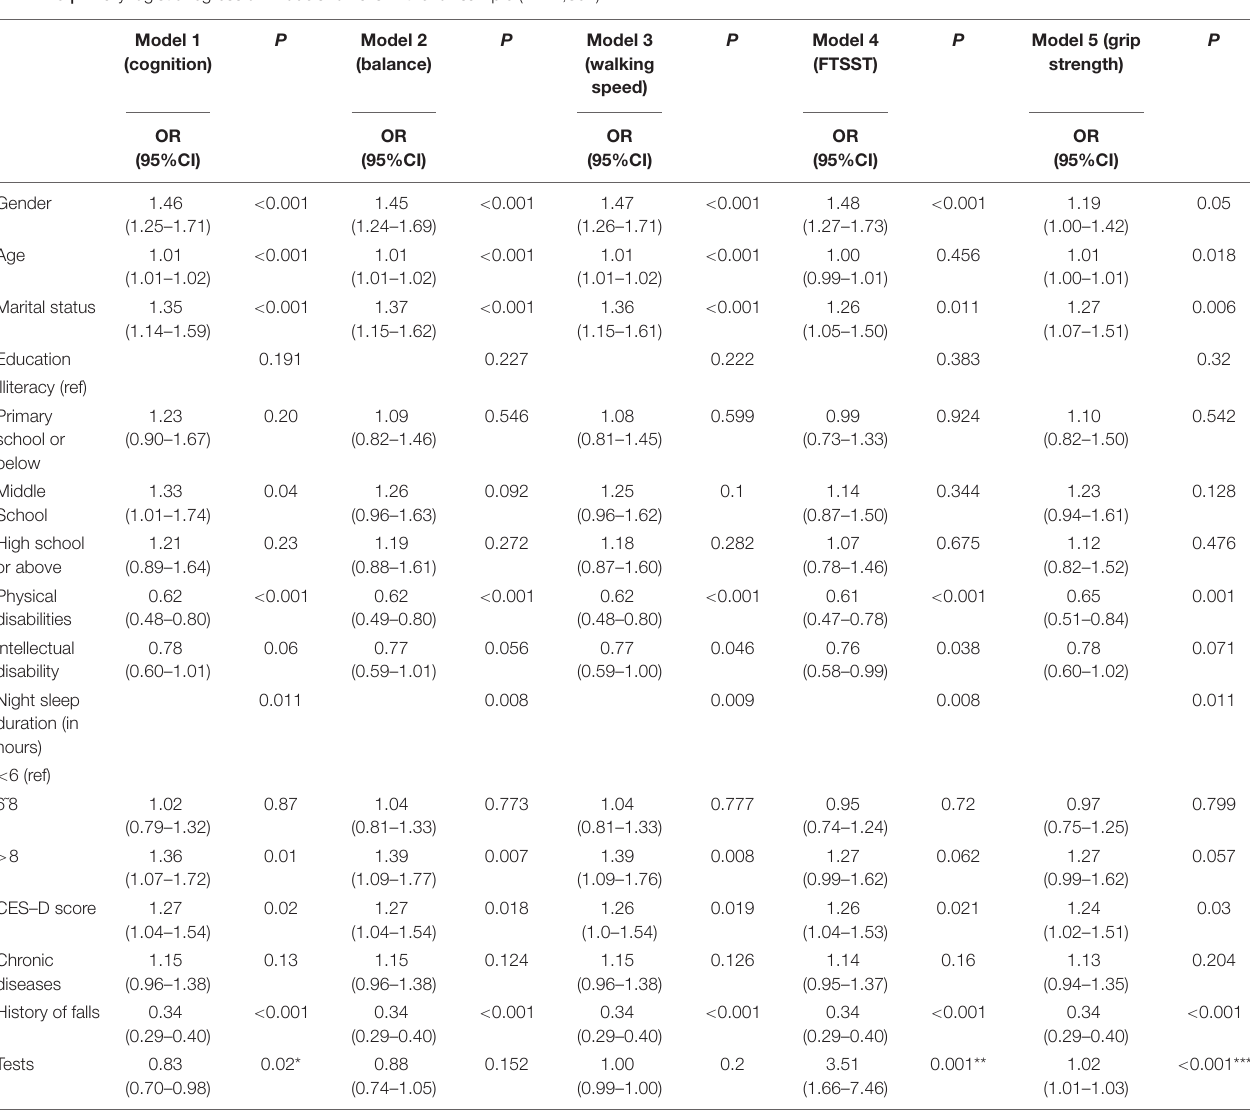
TABLE 3 | Binary logistic regression models for falls in the full sample ( n =